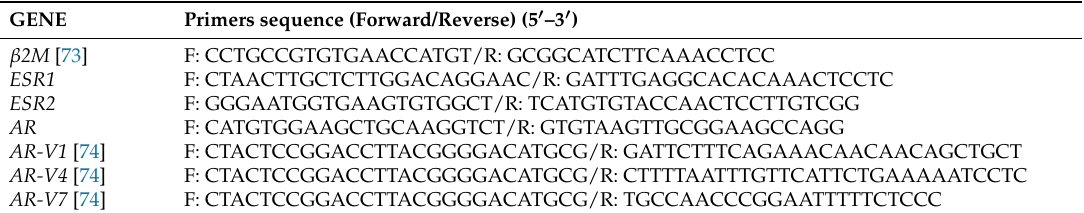
Table 2. Oligonucleotide sequences used for qPCR